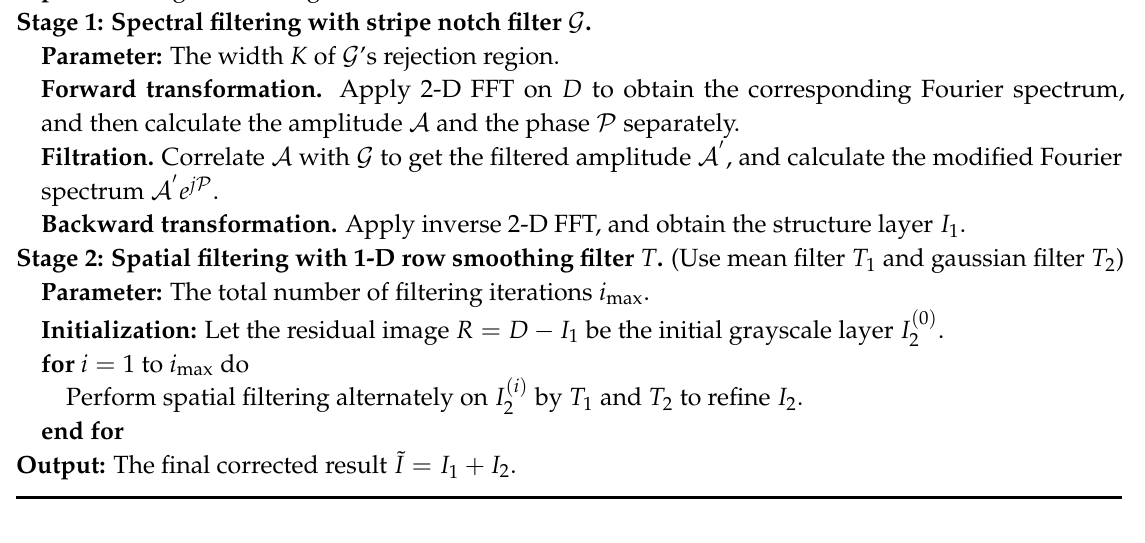
Algorithm 1. Two-stage filtering method for single IR image stripe nonuniformity